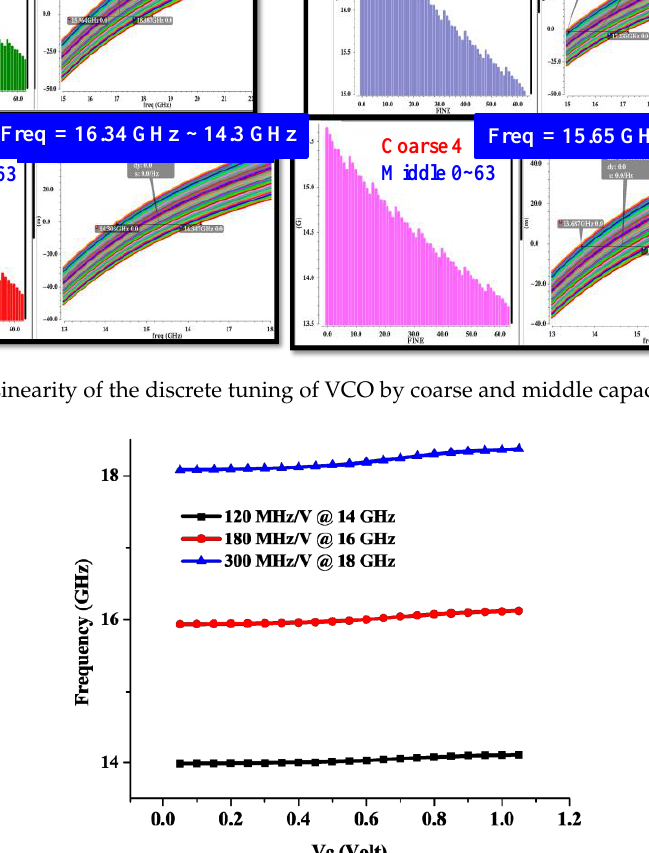
Figure 10. Continuous tuning of the VCO (KVCO).